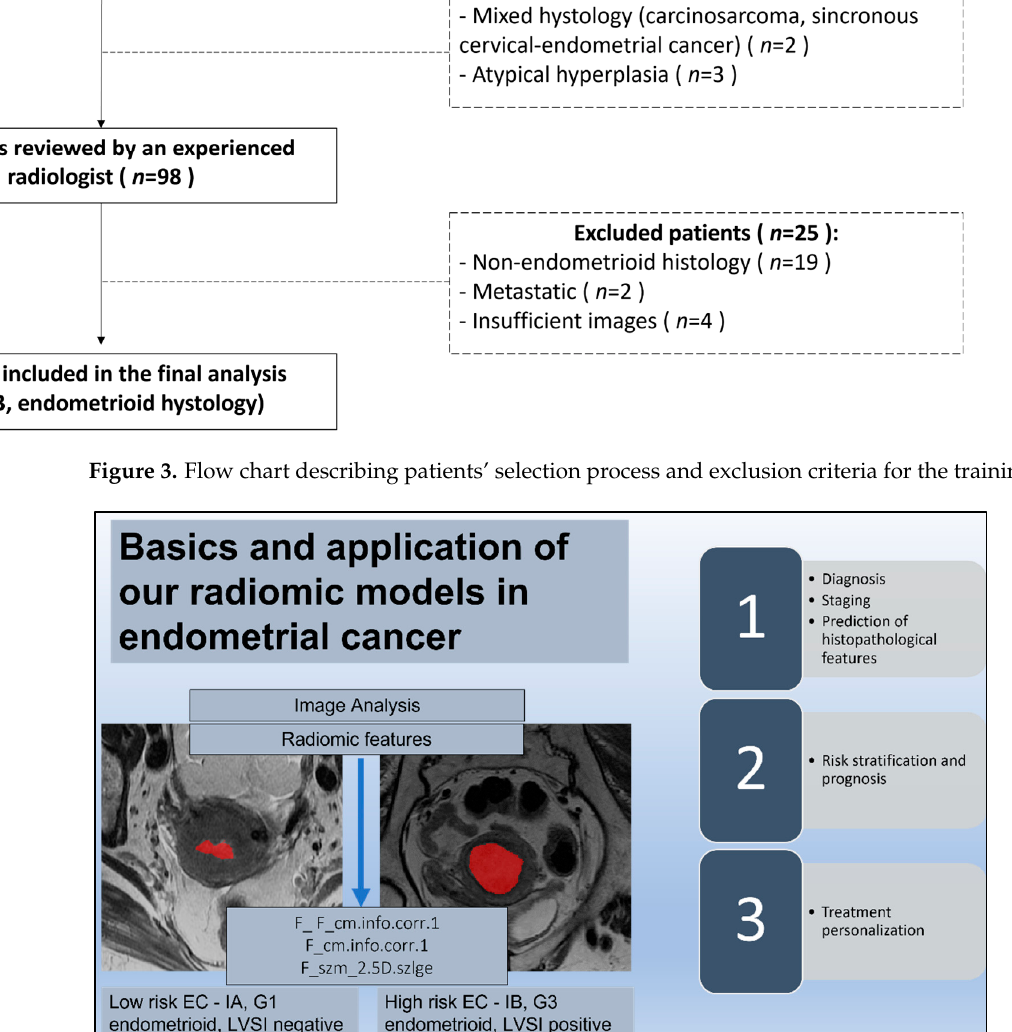
Table 3. Performance and Accuracy metrics of Radiomics Models in Training and Validation sets for predicting DMI and LVSI and discriminating low-risk group versus the other risk groups.